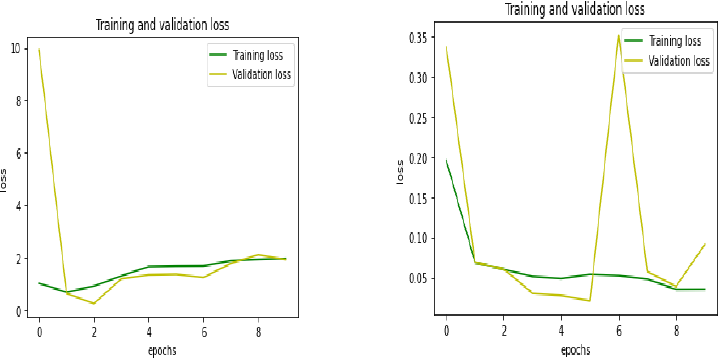
Figure 7. Training and validation loss for the existing and proposed systems.